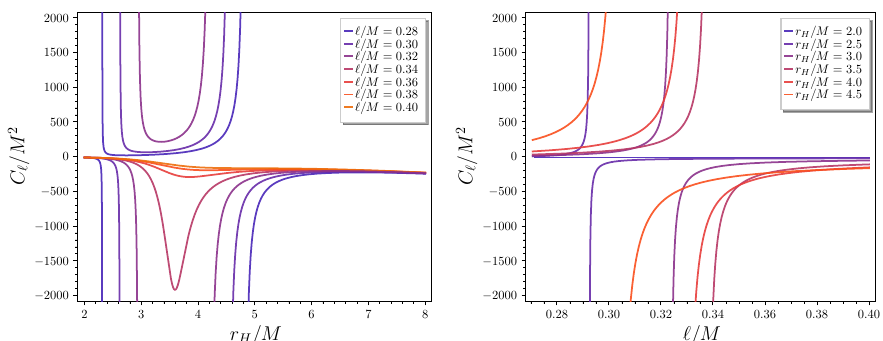
Figure 4. Left panel: heat capacity of hairy black holes depending on the horizon radius r H for different values of hairy parameter (cid:96) . Right panel: heat capacity of hairy black holes depending on the hairy parameter (cid:96) for different values of the horizon radius r H . In both cases the decoupling parameter α was eliminated using Equation (14) and the radius r H = 2 M corresponds to the extreme case. Notice the discontinuities for (cid:96) < 0.36 and r H <